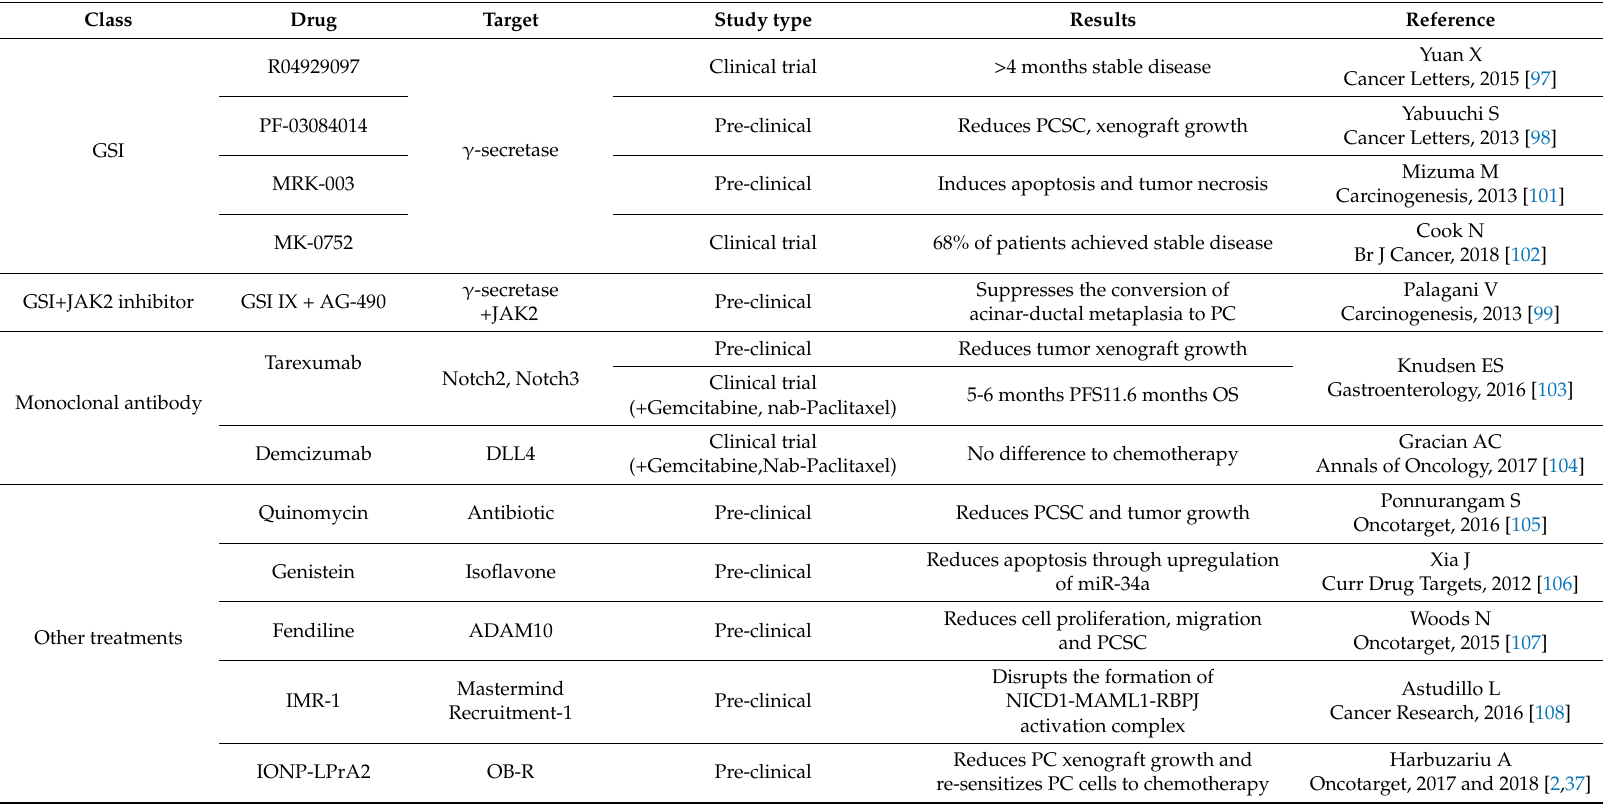
Table 1. Notch targeted therapy in